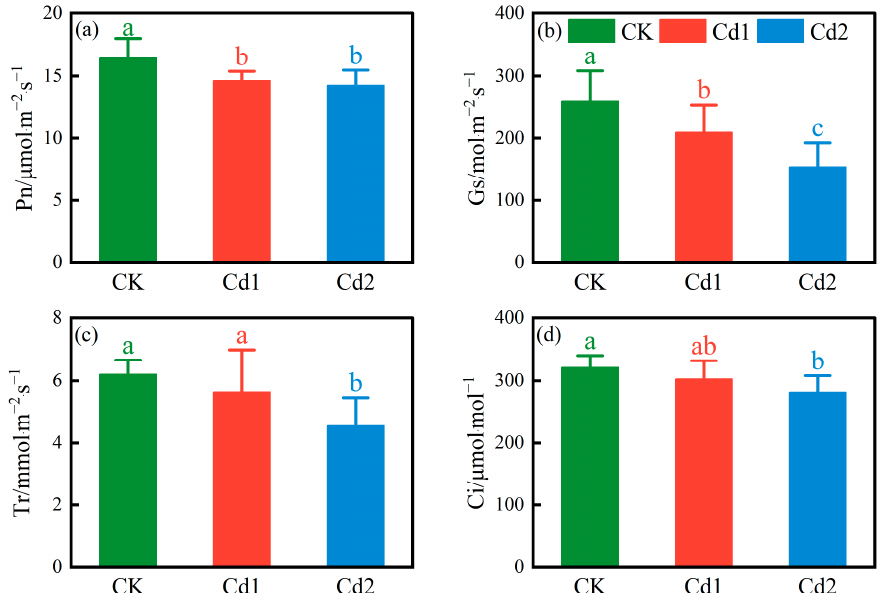
Figure 5. Changes in photosynthetic parameters of rice leaves under different Cd stress concentra- tions(( a ) Net photosynthetic rate (Pn); ( b ) Stomatal conductance (Gs); ( c ) Transpiration rate (Tr); ( d ) intercellular CO 2 concentration (Ci)), lowercase letters indicate significant differences.